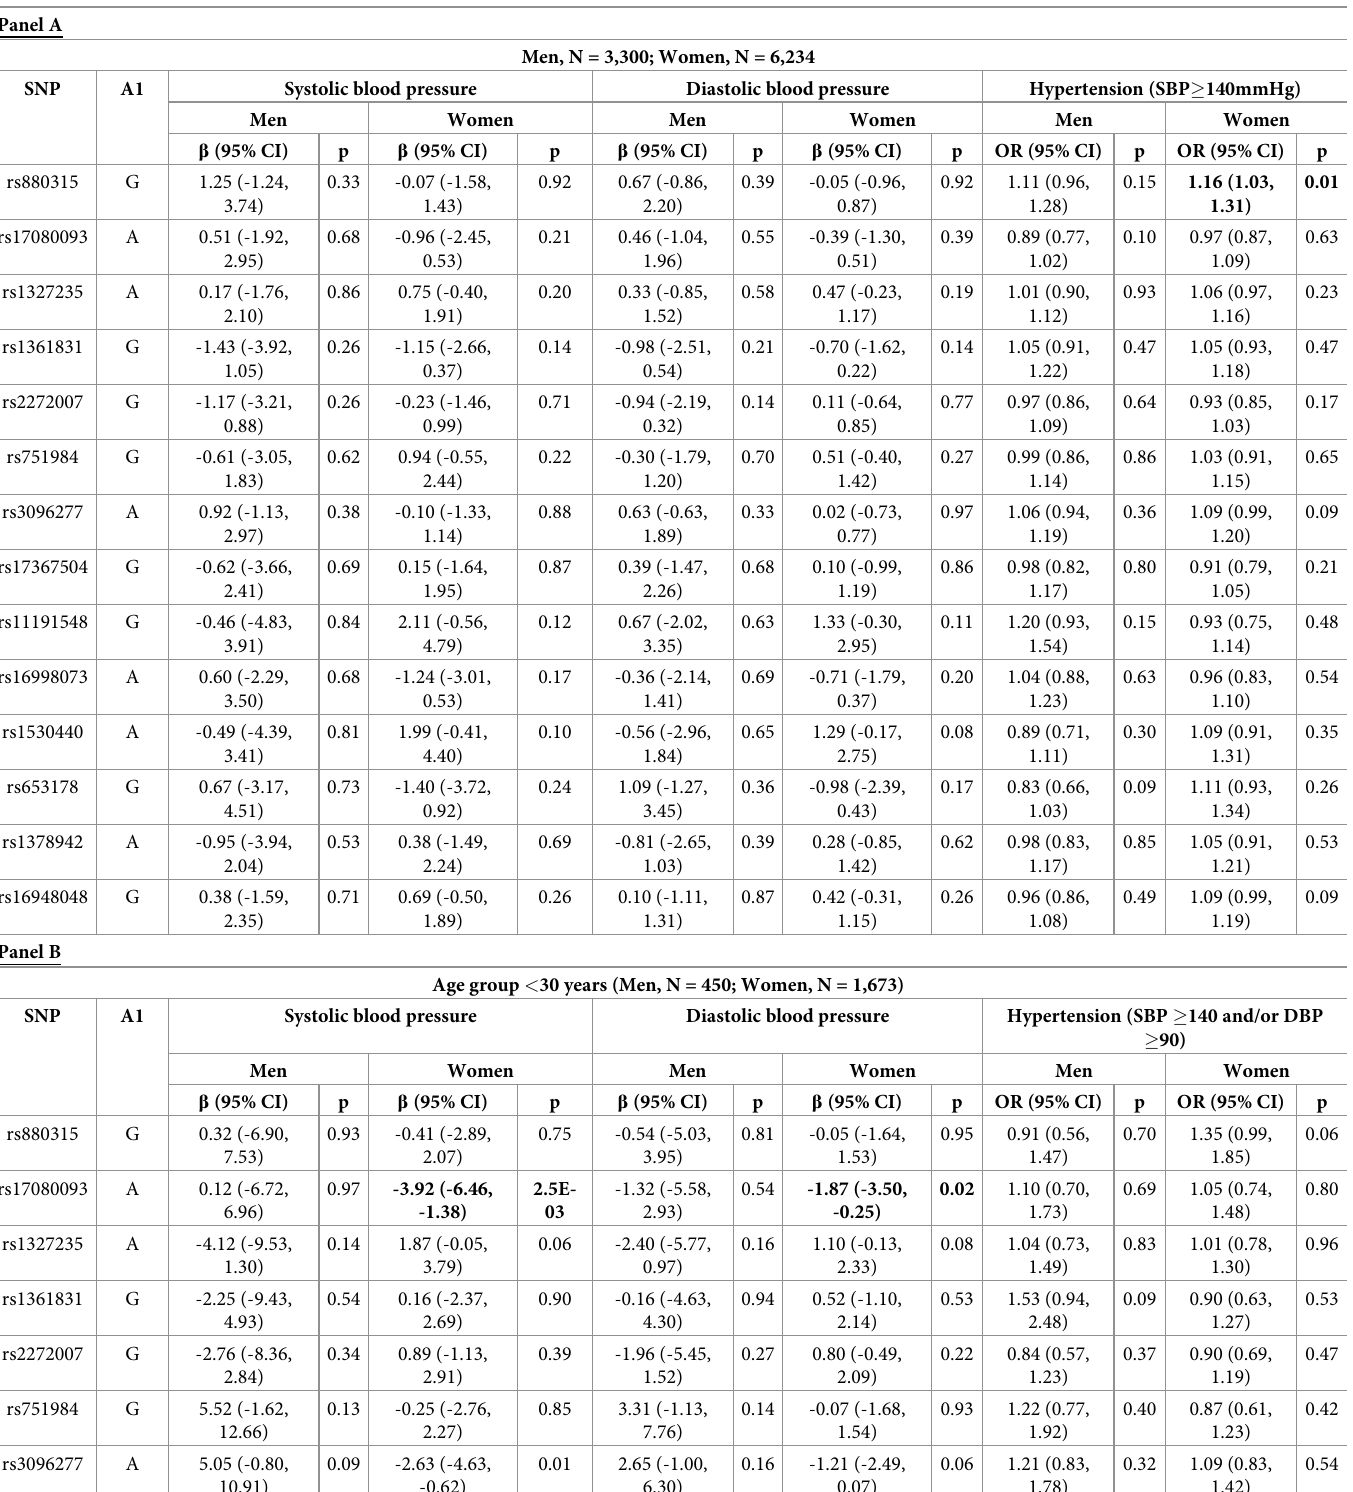
Table 4. Evidence of sex-specific association of SNPs with blood pressure traits (SBP, DBP and hypertension) among individuals with African-American ancestry. Panel